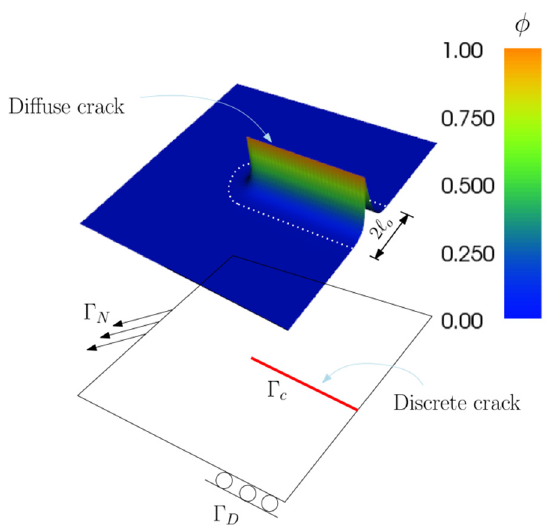
Figure 2. Schematic representation of the crack using discrete and diffuse approach. Within PFM framework scalar field variable, 𝜙 is used to represent the crack. Note that width of the diffuse crack is controlled by the characteristic length scale, ℓ (cid:3042)